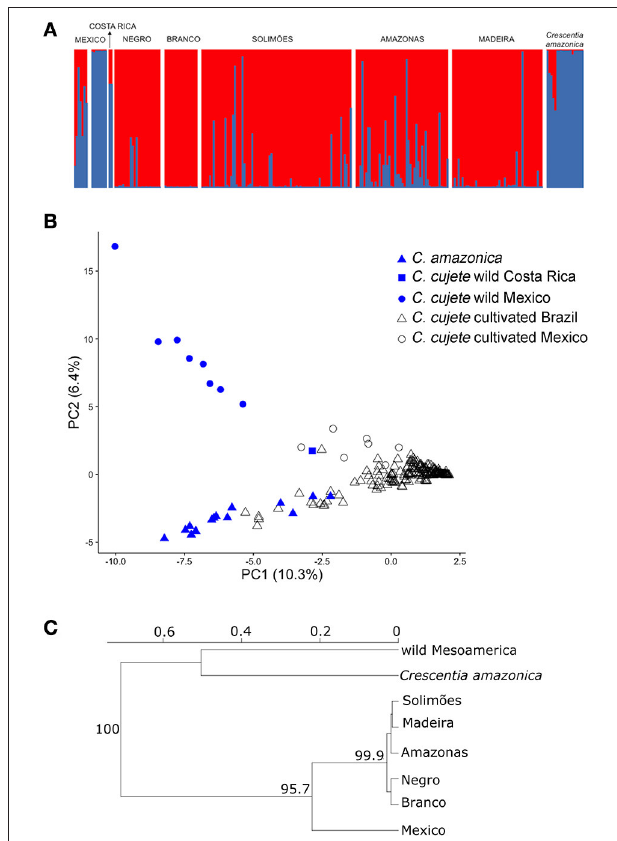
FIGURE 2 | Genetic structure of 250 cultivated and wild treegourds ( Crescentia cujete ; C. amazonica ) from Brazilian Amazonia and Mesoamerica based on 8 nSSR. Wild C. cujete were from the Yucatan Peninsula in Mexico and the Pacific coast of Costa Rica. (A) Structure plots at K = 2. The y-axis shows the proportion of assignment to the cluster and each vertical bar represents a single plant. The geographic locations and river basins are separated by white vertical columns; in Mexico, the first group is cultivated and the second is wild. (B) Principal components analysis (PCA) of nuclear genetic structure. The solid symbols represent the two species in Brazil, while the gray refers to wild and cultivated C. cujete in Mesoamerica. Numbers in parenthesis show the percentage of the allelic variation explained by each axis. (C) Neighbor-joining tree of the geographic relationships between wild and cultivated samples based on Nei’s genetic distance with 1,000 bootstraps supports indicated on the